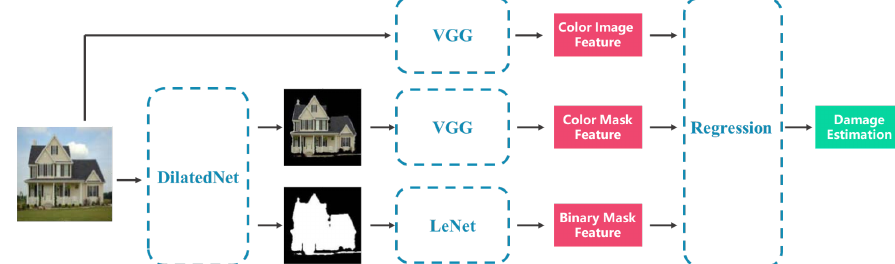
Figure 8. An example of transfer learning. First, we input the image to DilatedNet to obtain the color mask and binary mask. Then, the original image, color mask and binary mask are input to VGG, VGG and LeNet respectively for extracting corresponding features. Finally, we input three features to regression network and output the estimated